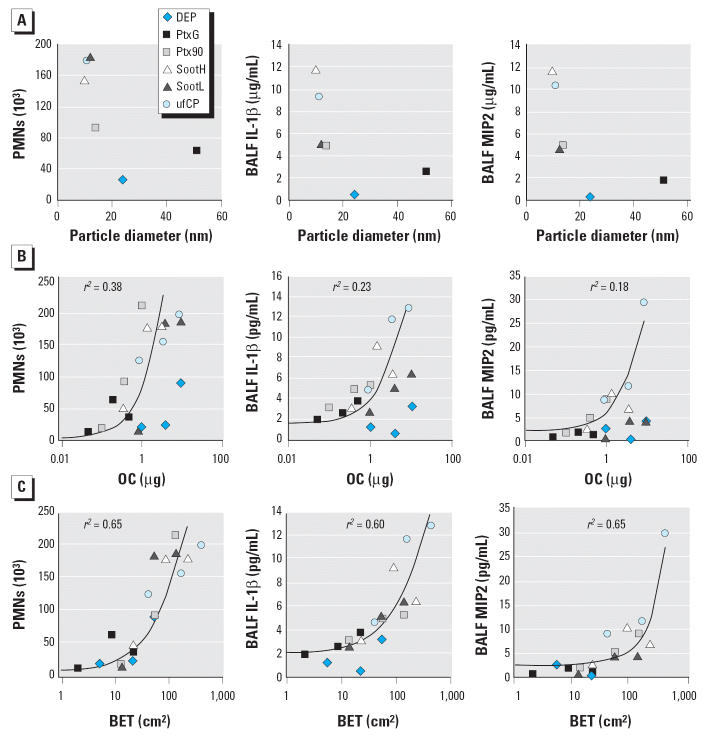
PMN cell numbers and IL-1β and MIP2 concentrations are plotted as a function of different characteristics of the instilled UFPs: (A) primary particle diameter (for an exemplary dose of 20 μg); (B) OC mass; and (C) particle surface area (BET). Each symbol represents mean values of eight animals. A regression analysis revealed a strong logarithmic relation for the surface area (r2 = 0.65) and a weaker relation for the organic contribution (r2 = 0.38).